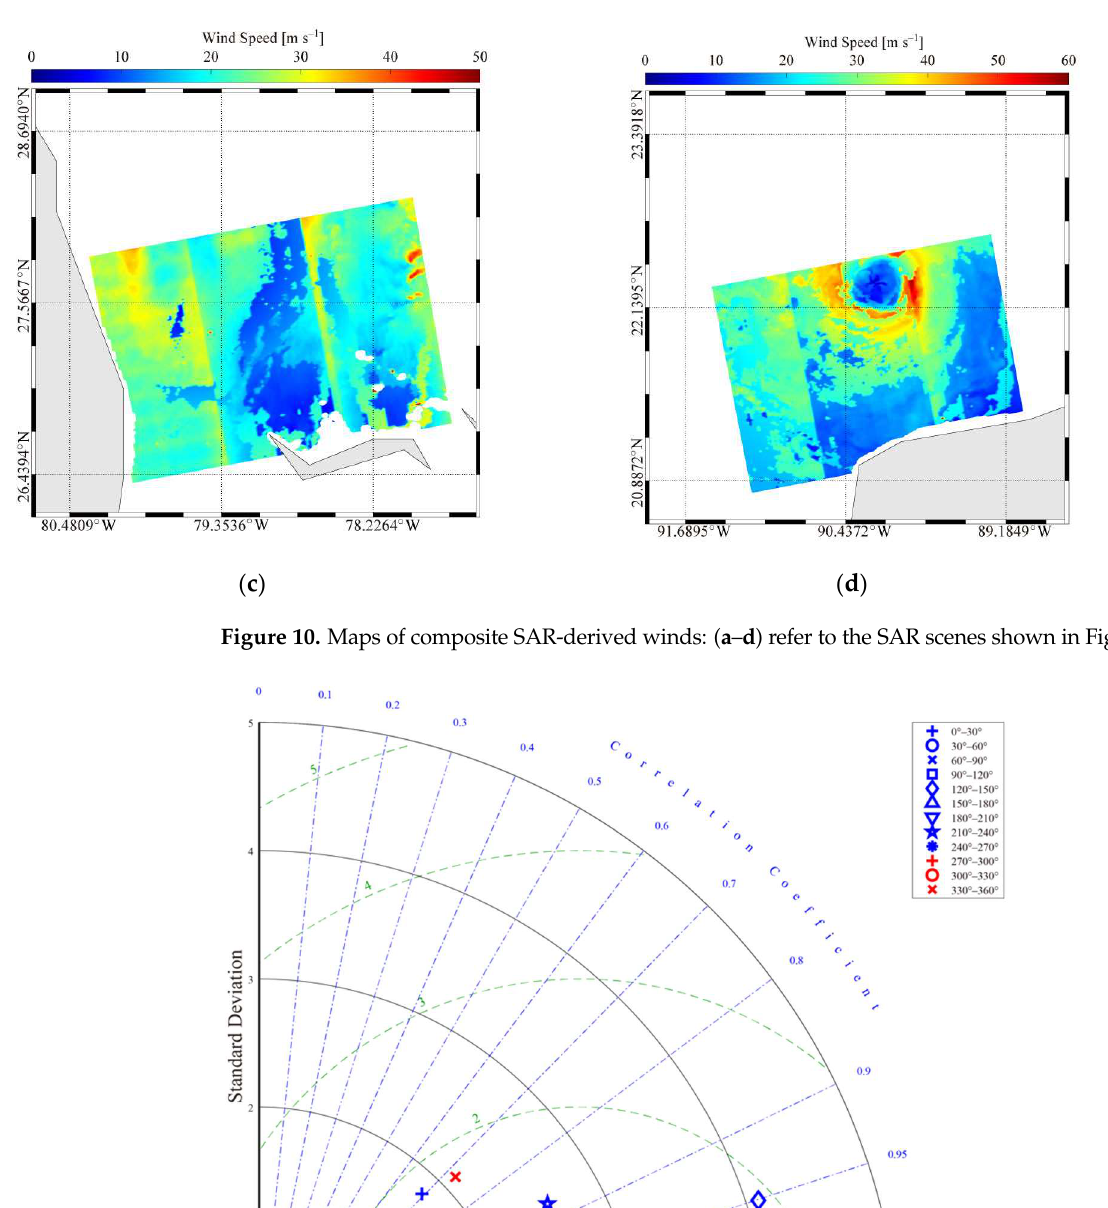
( b ) Figure 9. Wind speed in two radial profiles on the images of TC Irma overlaid by radial-vortex modeling winds at two flow directions: ( a ) 45  and ( b ) 135  . The red curve is the VH-polarized SAR- derived without rain, the blue curve is with rain and the black line is the model-simulated result.